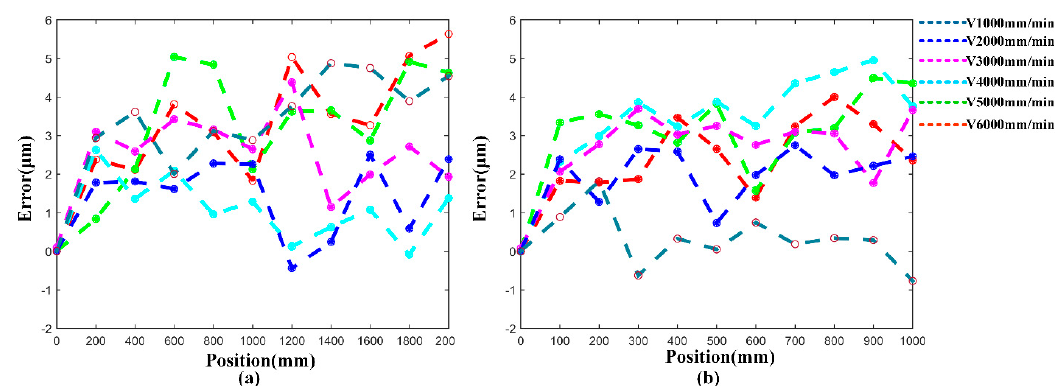
Figure 18. Traditional error compensation results. ( a ) Traditional error compensation results with the tool center moving along the X -direction; ( b ) traditional error compensation results with the tool center moving along the Y -direction.